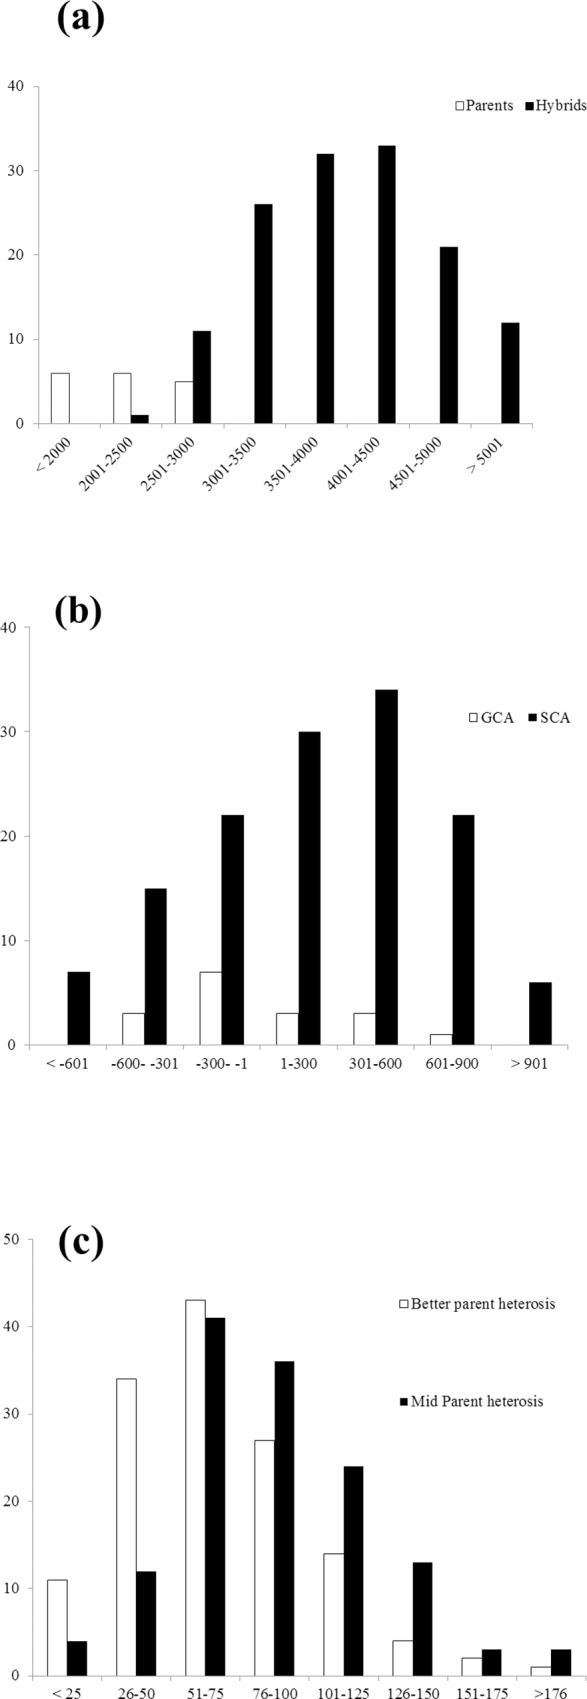
Distribution of (a) grain yield (kg ha-1), (b) general and specific combining ability and (c) mid and better parent heterosis, over 136 hybrids.